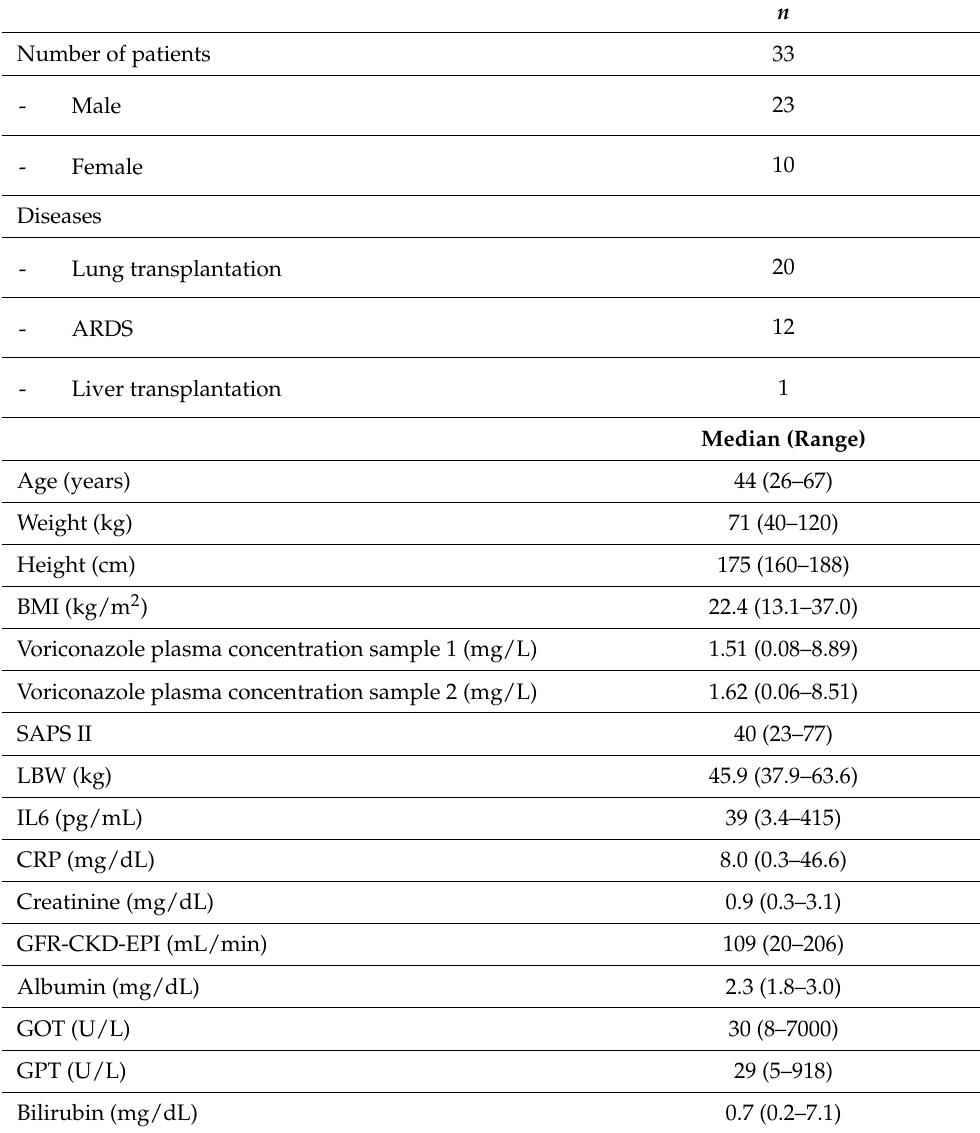
Table 1. Patient characteristics at initiation of VRC